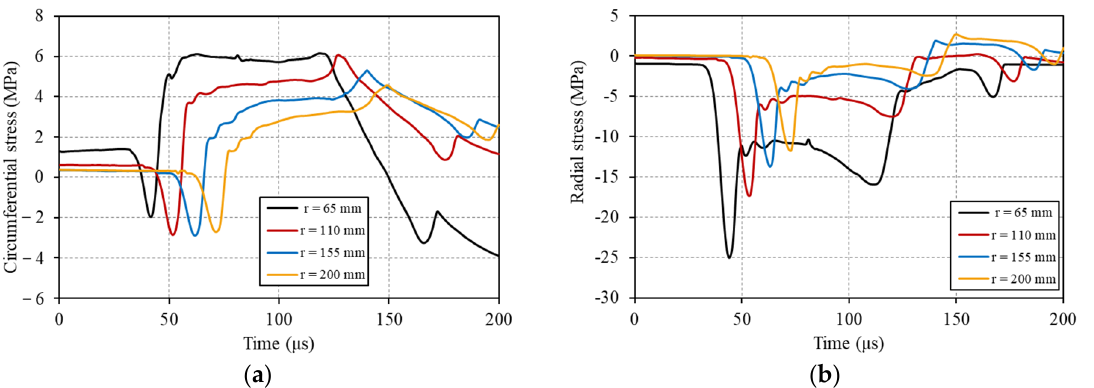
Figure 10. Stresses history at different locations in the rock when P c = 0 MPa and P h = 1 MPa: ( a ) circumferential stress; ( b ) radial stress.